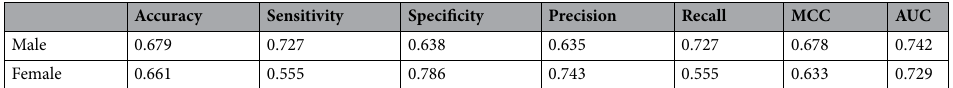
Accuracy Sensitivity Specificity Precision Recall MCC